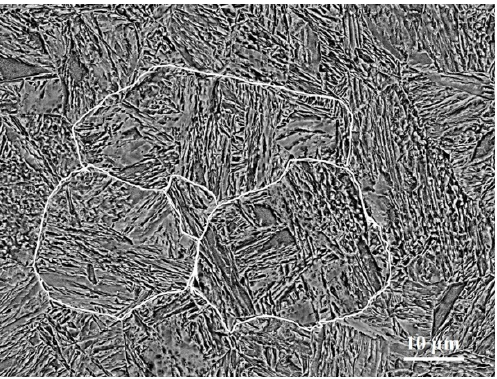
Figure 1. SEM-BSE (scanning electron microscope-backscatter electron) image of the tempered martensite prior to nitriding. The white lines mark the original austenite boundaries.